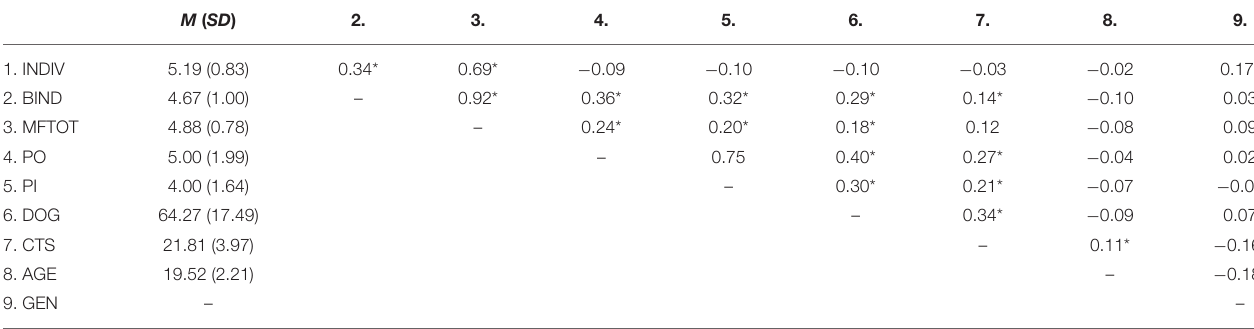
TABLE 5 | Study 2 interaction effects of language × reasoning style (continuous) regression on MFQ total scores, individuating, and binding subscales. MFTOT Interaction